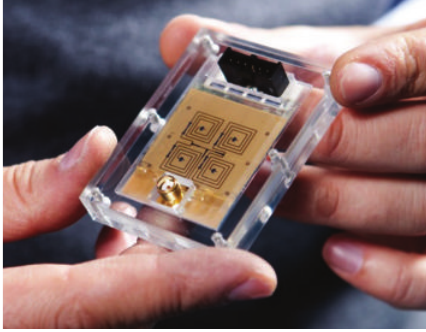
Figure 7: Prototype of the electronic beam steering liquid crystal phased array